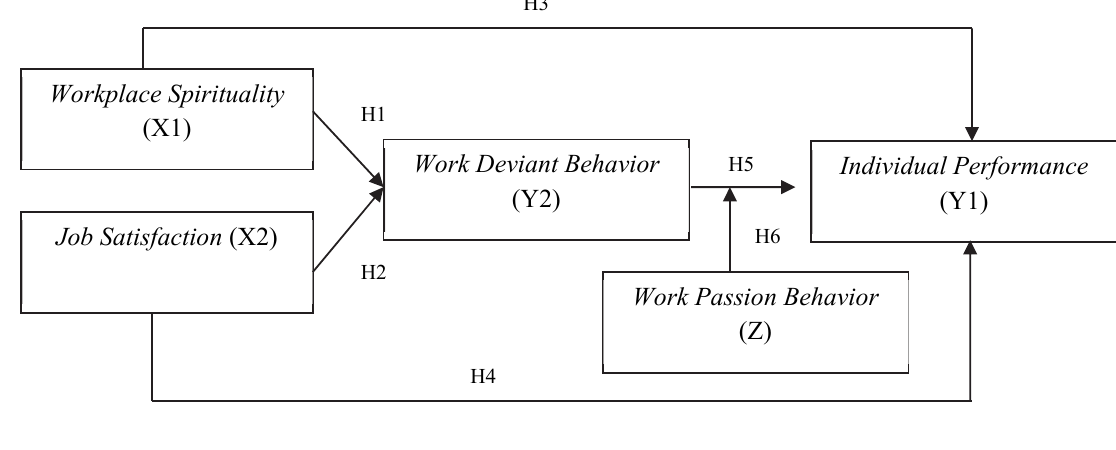
Fig. 1. Research Framework